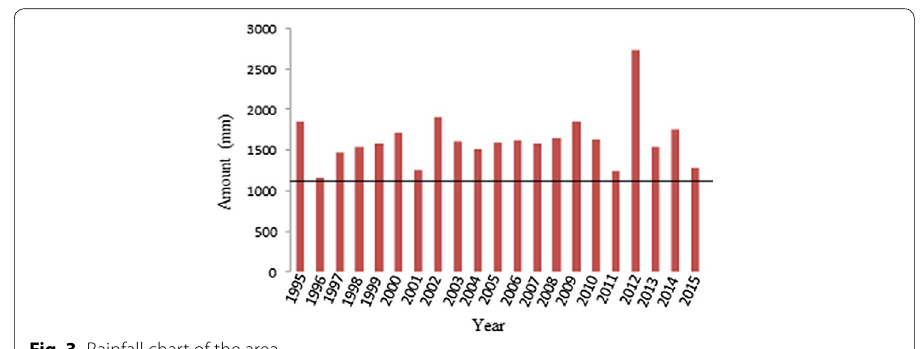
tributaries are perennial and usually overflow their banks at the peak of the rainy season. The drainage system of the area is dendritic pattern (Fig. 2), which is mostly controlled by the geology of the area (Fig.